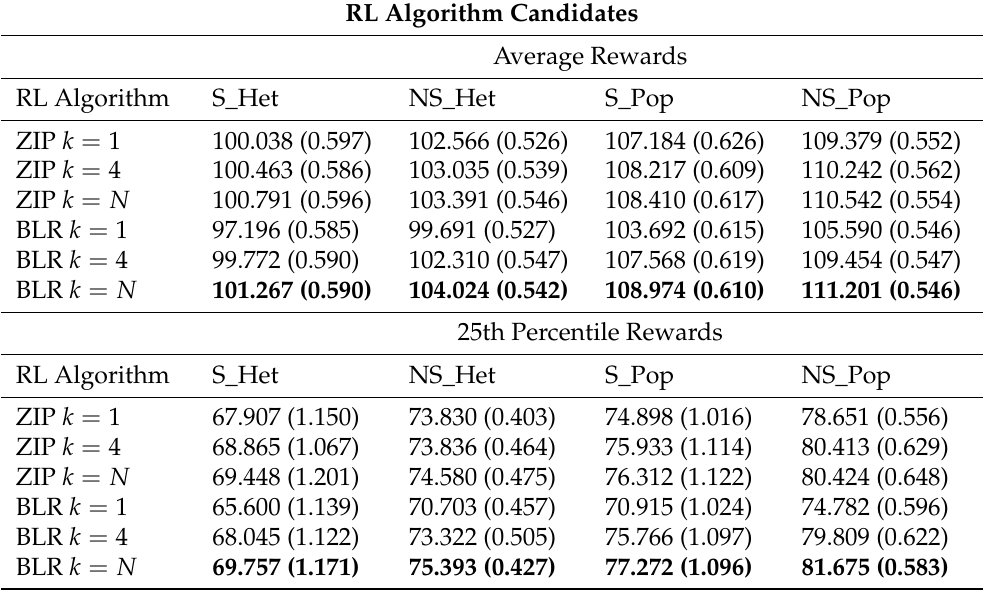
Table 2. Average and 25th Percentile Rewards. Average and 25th percentile rewards are defined in Section 3.1. The naming convention for environment variants is found in Table 1. “k” refers to the cluster size. Average rewards are averaged across time, users, and 100 trials. For the 25th percentile rewards, we average rewards for each user across time, find the lower 25th percentile across N = 72 users, and then average that across 100 trials. The value in the parenthesis is the standard error of the mean. The best performing algorithm candidate in each environment variant is bolded. BLR ( k = N ) performs better than other algorithm candidates across all simulated environments. Notice that the average rewards are lower than the 120-s dentist-recommended brushing duration. This is because of the zero-inflated nature of our setting (i.e., the user does not